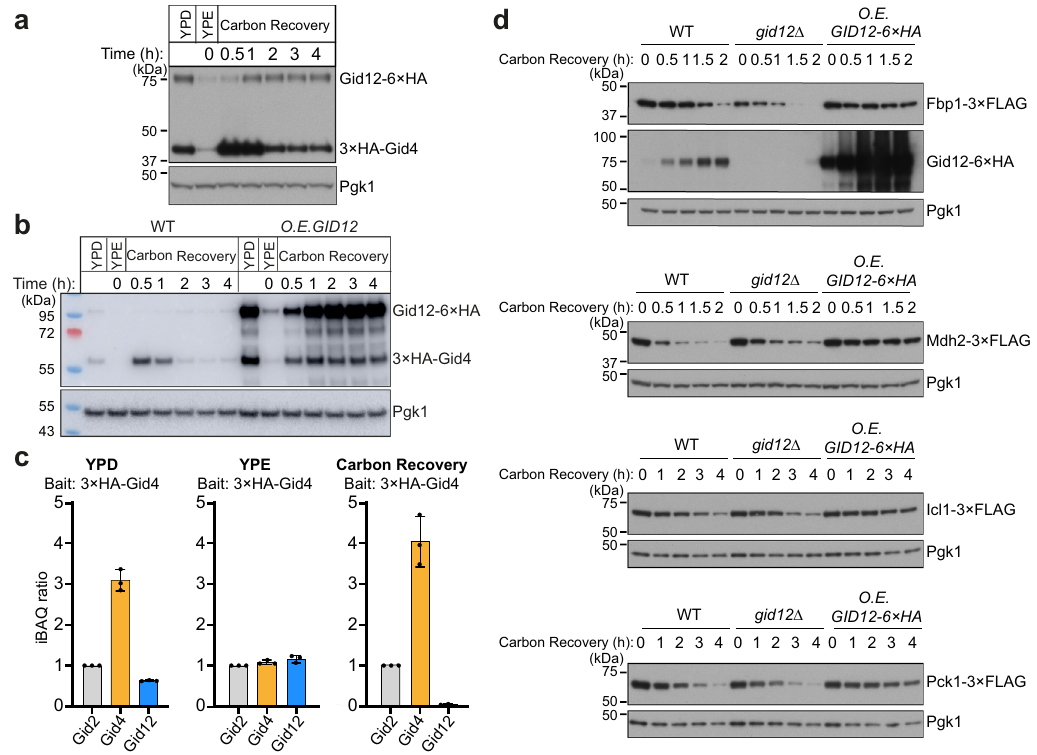
Fig. 7 Overexpression of Gid12 stabilizes Fbp1 in vivo. a Expression pro fi les of Gid4 and Gid12 tagged at their endogenous loci, under different growth conditions, monitored by western blotting against hemagglutinin tag (HA). YPD: glycolytic conditions; YPE: overnight non-fermentable carbon source starvation; Carbon Recovery: glucose replenished with YPD. Pgk1 served as loading control ( n = 3 biologically independent experiments). b Degradation of 3×HA chromosomally tagged Gid4 in wildtype (WT) and Gid12-overexpressing ( GPD promoter) cells were monitored using anti-HA immunoblotting. Gid4 was stable under carbon recovery conditions in a strain continuously overexpressing Gid12 ( n = 3 biologically independent experiments). c Quantitative mass spectrometry analysis of the relative levels of Gid2, Gid4 and Gid12 in anti-HA immunoprecipitates of lysates expressing Gid4 with an N-terminal 3×HA tag at the endogenous loci. Yeast cells were grown under glycolytic (YPD), non-fermentable carbon source starvation (YPE), or carbon recovery conditions. Data are mean ± s.d. of n = 3 biologically independent experiments. iBAQ ratios are formed using the respective Gid2 iBAQ value as denominator. d Monitoring degradation of 3×FLAG chromosomally tagged gluconeogenic enzymes in wildtype (WT), Gid12-de fi cient ( gid12 Δ ), and Gid12- overexpressing ( ADH1 promoter) cells using anti-FLAG immunoblotting. The effects of GID12 deletion to gluconeogenic enzymes are subtle, however, all four gluconeogenic enzymes are stabilized under carbon recovery conditions in a strain consecutively overexpressing Gid12 ( n = 3 biologically independent the Fbp1 degron. Second, despite the potential to be part of an active E3 ligase, Gid12 precludes productive Fbp1 ubiquitylation (Fig. 6e), by sterically blocking the globular Fbp1 enzymatic domain from accessing the central space within the Chelator- GID SR4 (and Cage-GID SR4 , which encompasses Chelator- GID SR4 ) supramolecular assemblies (Figs. 4, 5). Previous studies